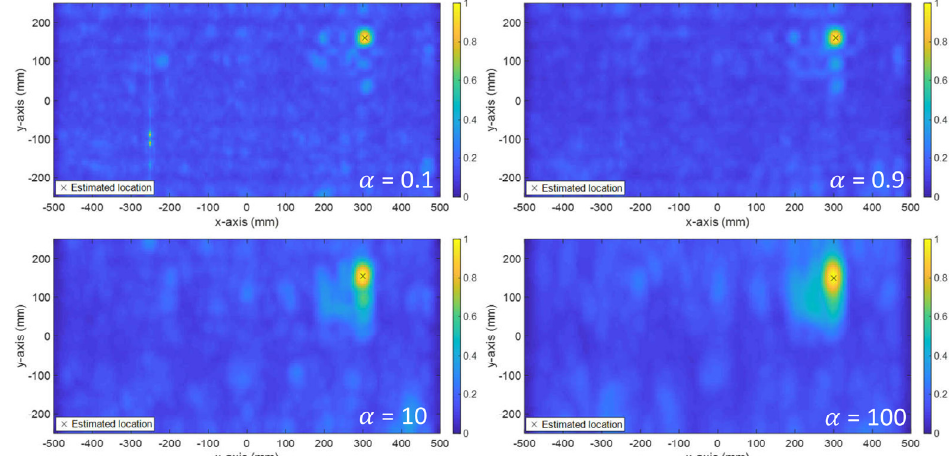
Figure 14. The distribution of the normalized maximum electric field power over the complete simulation time interval in the computational domain for different values of 𝛼 .